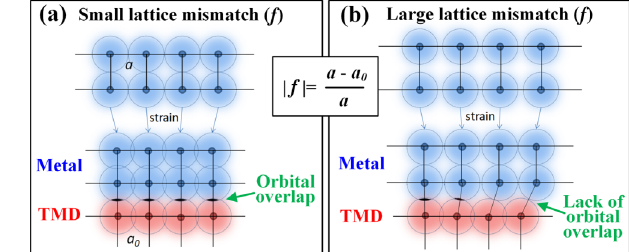
FIG. 5. Schematics showing the impact of lattice mismatches in metal-TMD contact. (a) Small lattice mismatch that maximizes the orbital overlaps between metal and TMD. (b) Large lattice mismatch that prevents maximizing the orbital overlaps.